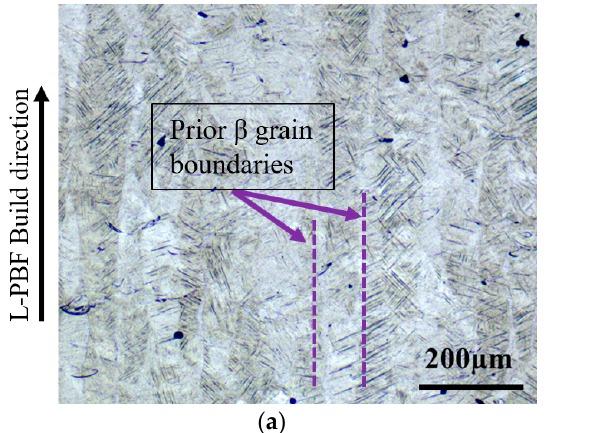
Figure 8. Optical micrographs of transverse sections of L-PBF parts after etching ( a ) horizontally built cylinder and ( b ) vertically built cylinder.